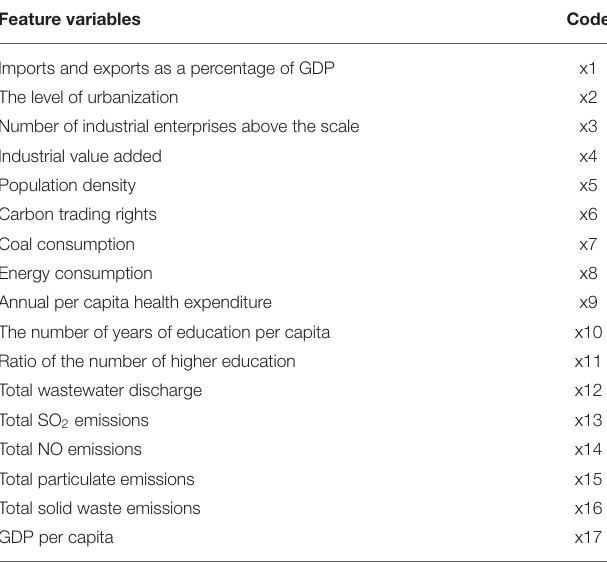
TABLE 1 | Corresponding codes of characteristic variables.